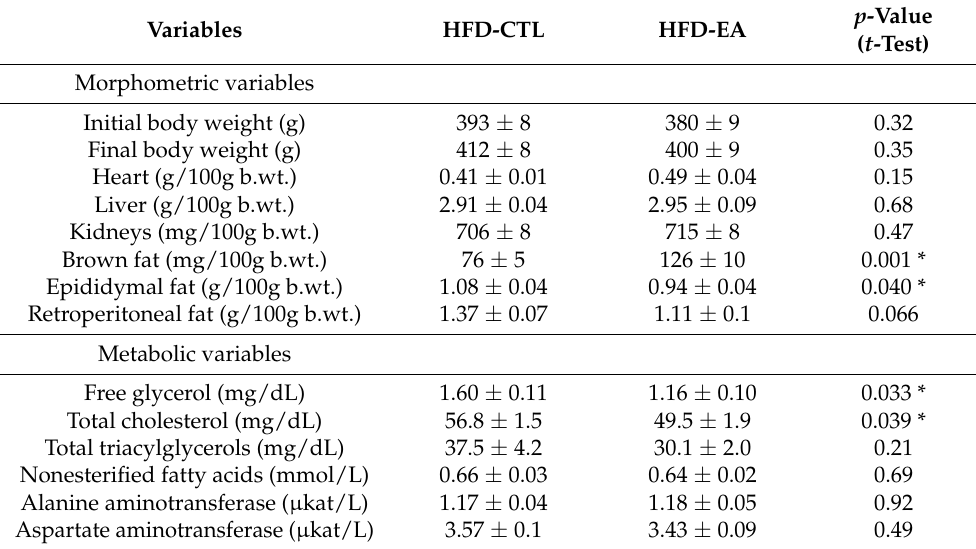
Table 1. Effect of ellagic acid supplementation on morphometric and metabolic variables in HFD-CTL and HFD-EA rats.